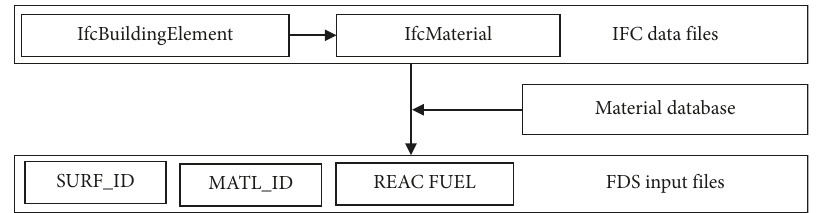
Figure 16: Material conversion method.